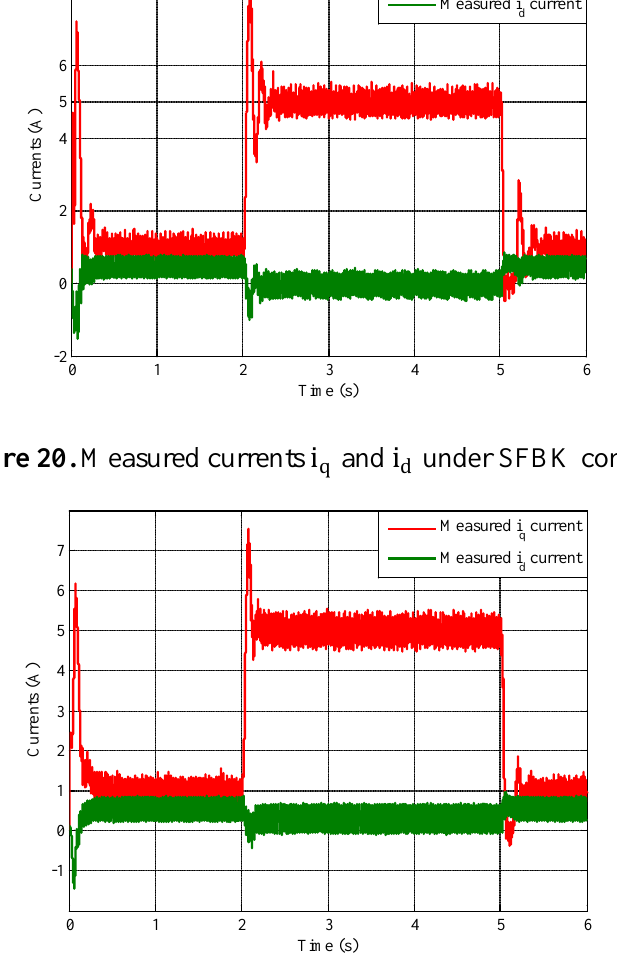
and under IP control. i q i d